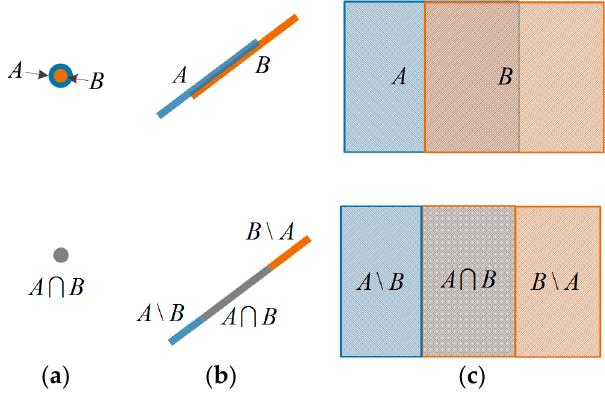
Figure 8. Removal of overlaps between footprint points ( a ), footprint edges ( b ) and footprint faces ( c ) by the combination of Boolean set operations.